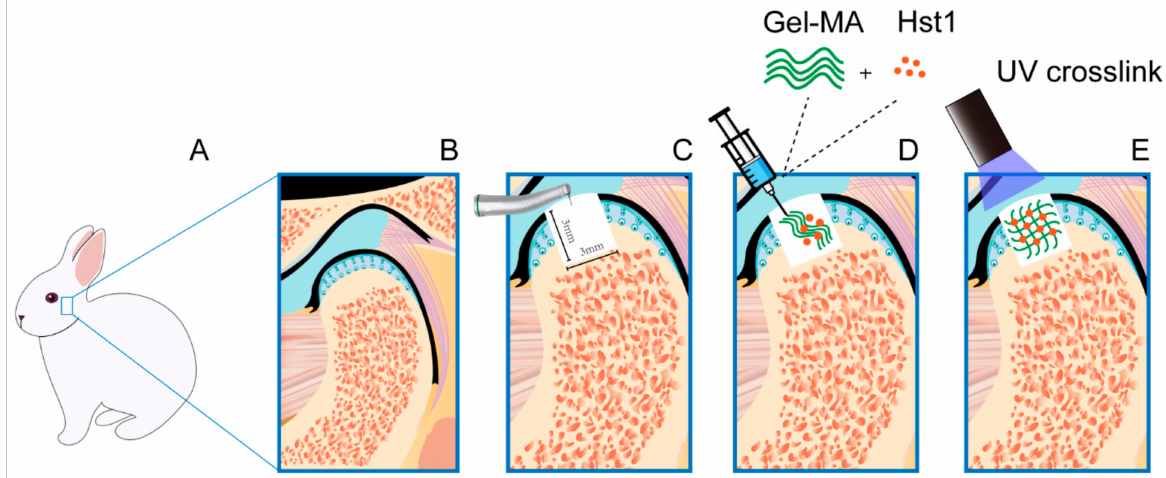
Figure 8. The schematic diagram ( A – E ) of the rabbit mandibular joint condyle critical-size (3 mm in diameter and 3 mm in depth) osteochondral defects model (3 mm × 3 mm) established